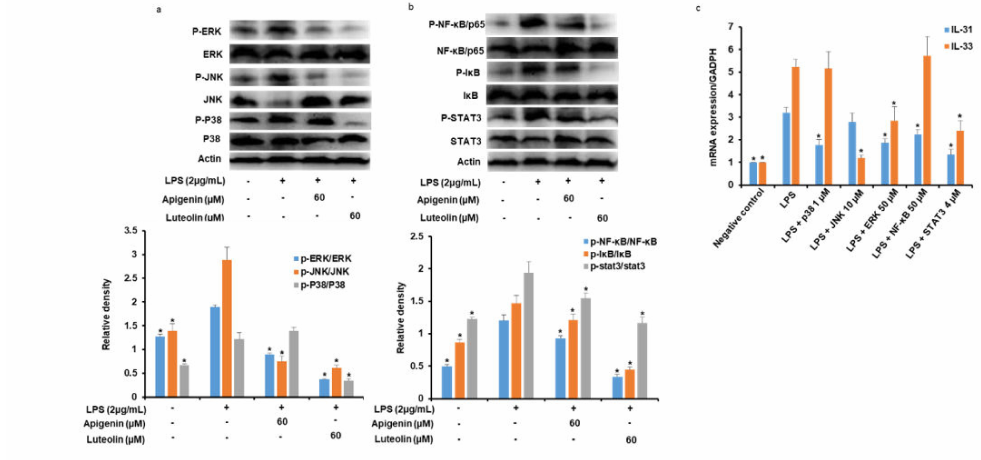
Figure 5. Apigenin and luteolin regulate the activation of mitogen-activated protein kinase (MAPK), NF- κ B, and STAT signal pathways in LPS-induced microglial activation. Microglia cells (5 × 10 5 cells / mL) were cultured and pre-treated with apigenin or luteolin ( a,b ) or p38, JNK, ERK, NF- κ B, or STAT3 potent inhibitors ( c ) and then stimulated with LPS for 30 min. The protein expression levels of cell signaling kinases were investigated by western blot assay and the band densities were analyzed using ImageJ analysis software, with respect to actin ( a,b ). The mRNA expression levels of IL-31 and IL-33 were investigated by quantitative real-time PCR analysis ( c ). The results are presented as the mean ± SD ( n = 3). The asterisk (*) indicates a significant di ff erence at * p < 0.05 compared to the LPS-only treated cells for bars with the same